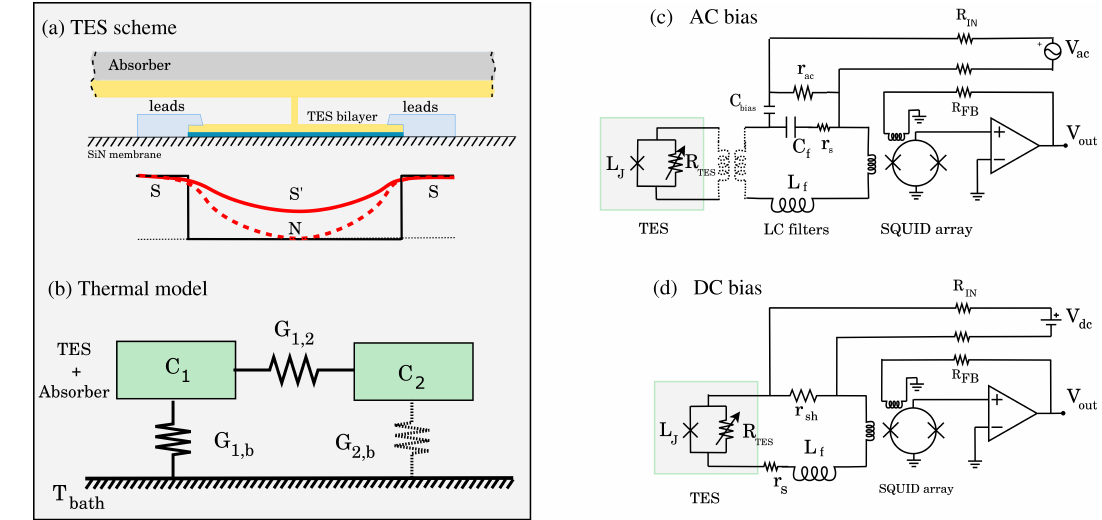
Figure 1. ( a ) Schematic diagram of a TES bilayer connected to the bias leads and the absorber. The red curves represent the superconducting order parameter for an SS’S (solid) and a SNS (dashed) TES weak-link. ( b ) Thermal model of a TES-Absorber system ( C 1 ) including a second thermal body C 2 . G 1, b is the main thermal conductance to the bath, G bath , and G 2, b (cid:28) G 1, b . ( c , d ) The electrical circuits for the ac and dc bias read-out,